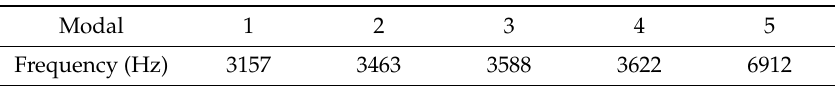
Figure 5. Modal simulation results. ( A ) Drive mode with in-phase movement; ( B ) Sense mode with in-phase movement; ( C ) Sense mode with anti-phase movement; ( D ) Drive mode with anti-phase movement. Table 2. First fifth modes of the DDMG.